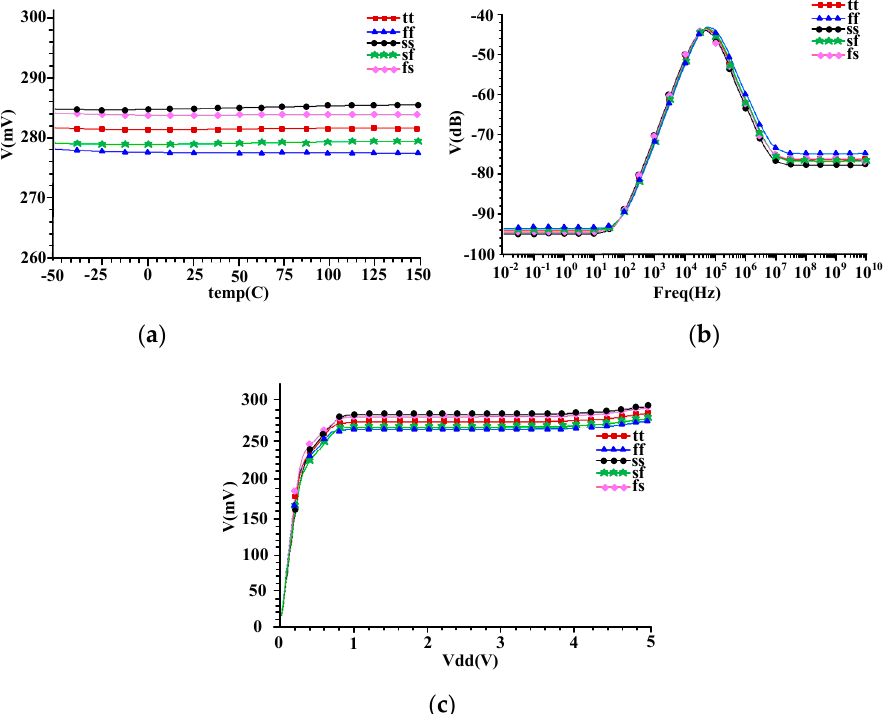
Figure 4. Simulation of Vref1 on different process corners: ( a ) simulation TC of Vref1 ; ( b ) simulation PSRR of Vref1 ; and ( c ) simulation LS of Vref1 .